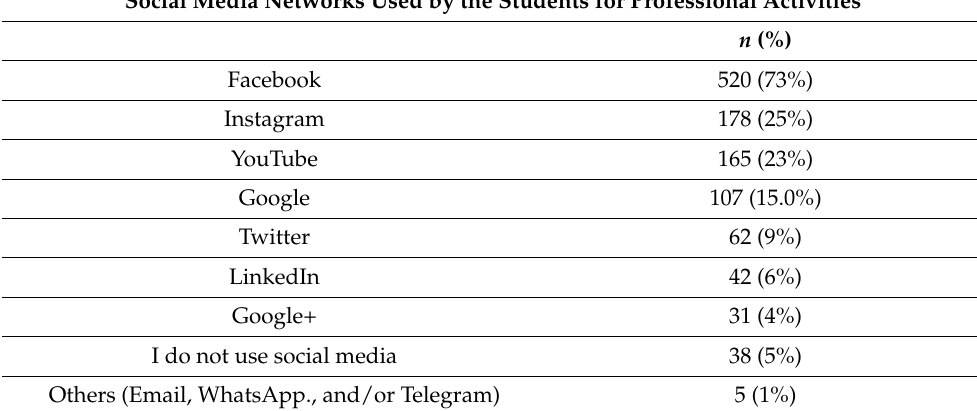
Table 2. Social media networks used by the students for professional activities and the information resources used by the students regularly in the management of infections ( n =